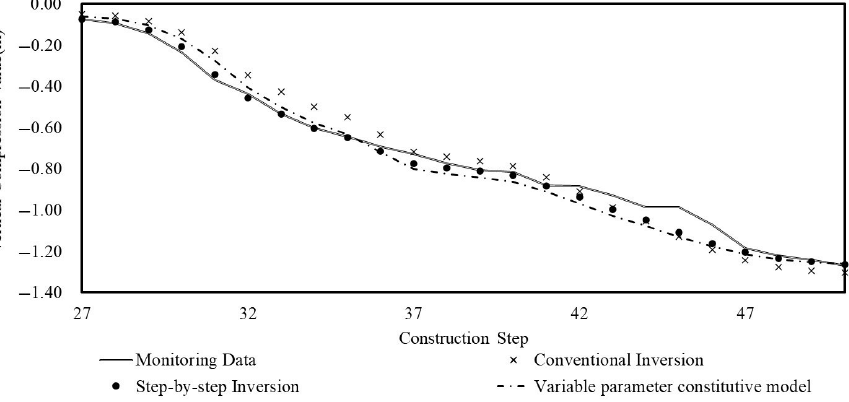
Figure 10. Comparison of compression values of the bottom of the core wall using variable parameter constitutive model.